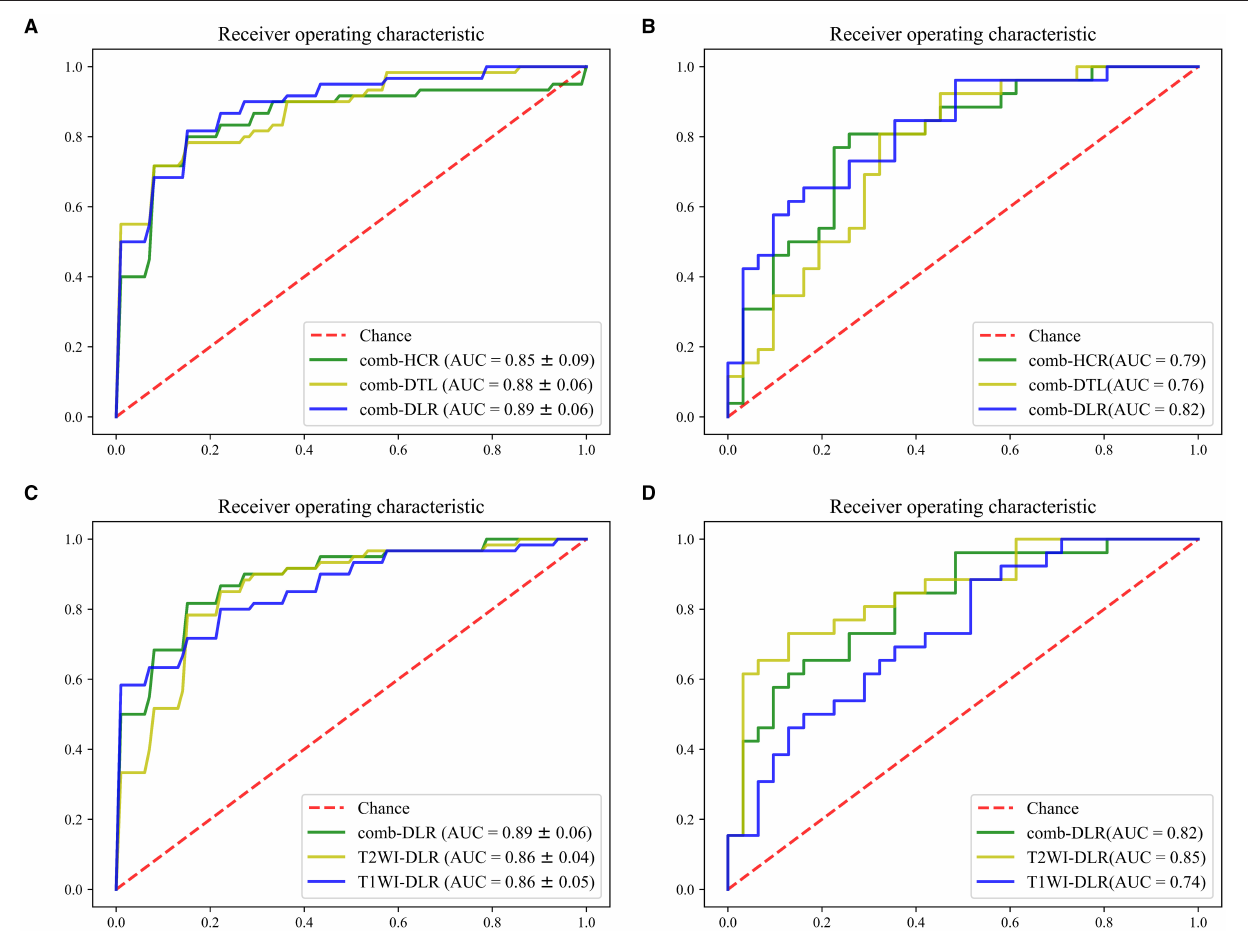
FIGURE 3 | ROC comparison. (A,B) , comb-HCR vs. comb-DTL vs. comb-DLR in the training cohort (A) and test cohort (B) . (C,D) T1WI-DLR vs. T2WI-DLR vs. comb-DLR in the training cohort (C) and test cohort (D)